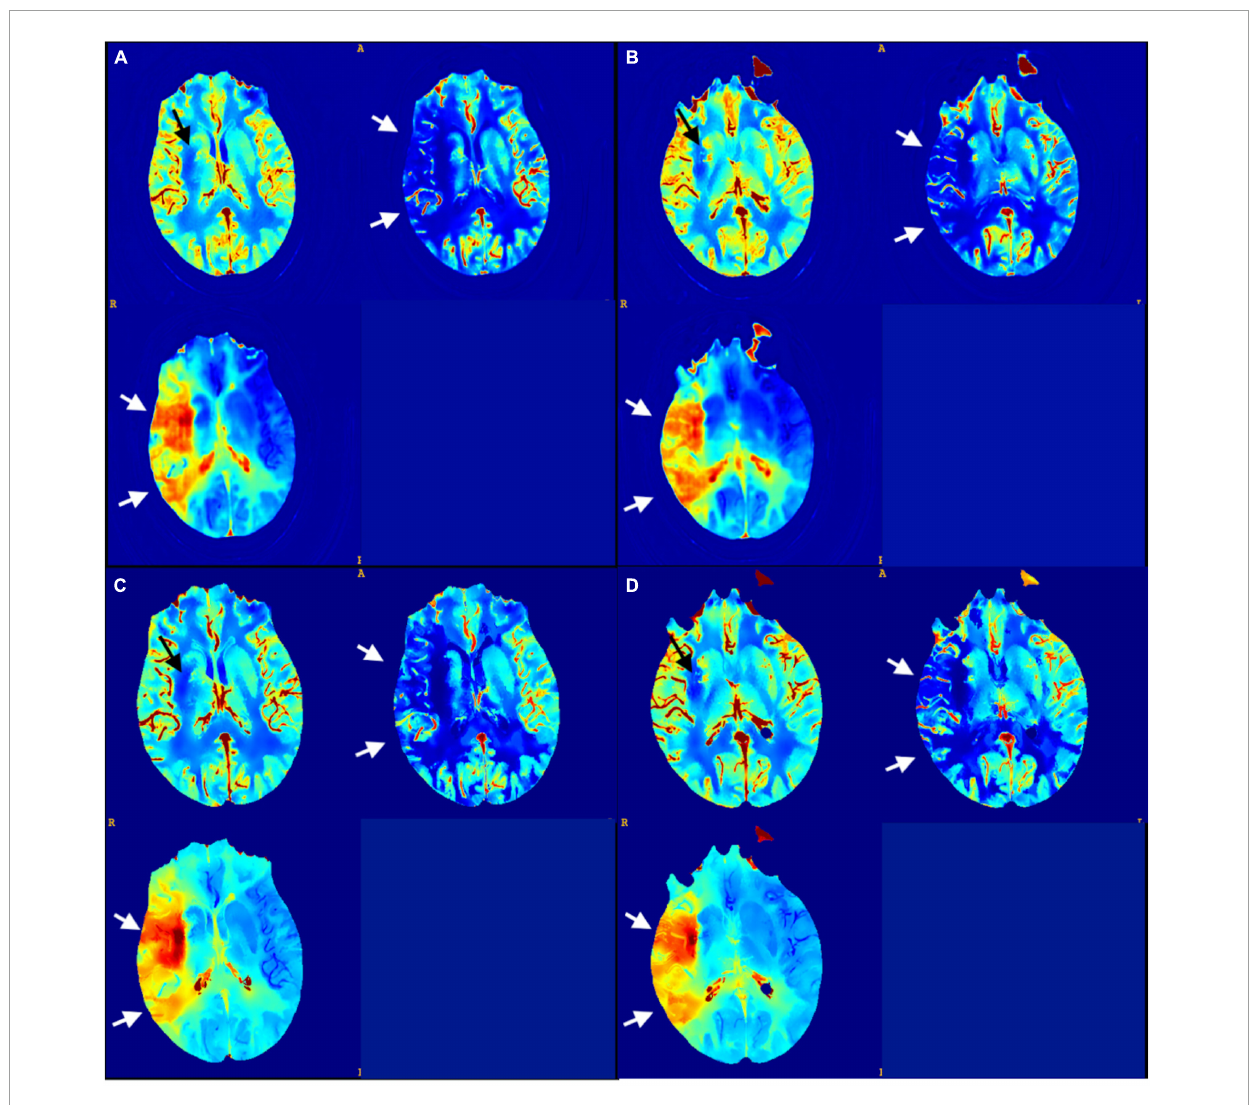
FIGURE2 (A,B) CNN output maps from the testing set (CBV, CBF, and TTP); (C,D) matching sections of GT maps. There is a small infarct core displayed in the CBV map at the right basal ganglia (black arrows) and an extended penumbra showed in the CBF and TTP maps across right middle cerebral artery territories (white